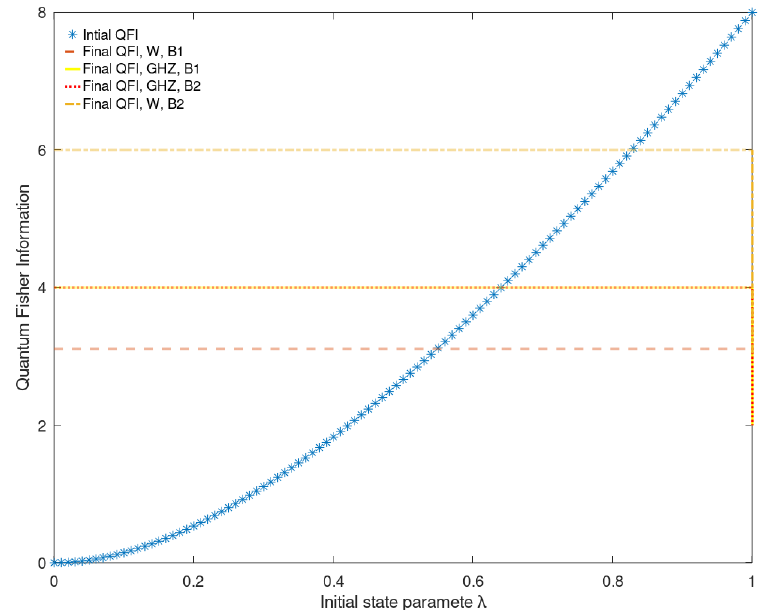
Figure 3. Comparison between the quantum Fisher information attainable by Alice’s initial state ρ A and the average over the quantum Fisher information obtained by Bob’s final states, using 3-qubit GHZ state and 3-qubit W state as channels. The blue line marked with ’*’s shows the variation of the quantum Fisher information as obtained by Alice’s initial state with respect to the state parameter λ . The dotted and solid lines, respectively, depict the average quantum Fisher information obtained by Bob’s final states, when Alice measures her qubit in bases B (cid:48) is used as a channel. The dashed and dashed-dotted lines represent Bob’s average QFI, when the 3-qubit W state is used as a channel, and Alice’s register is measured in bases B (cid:48)